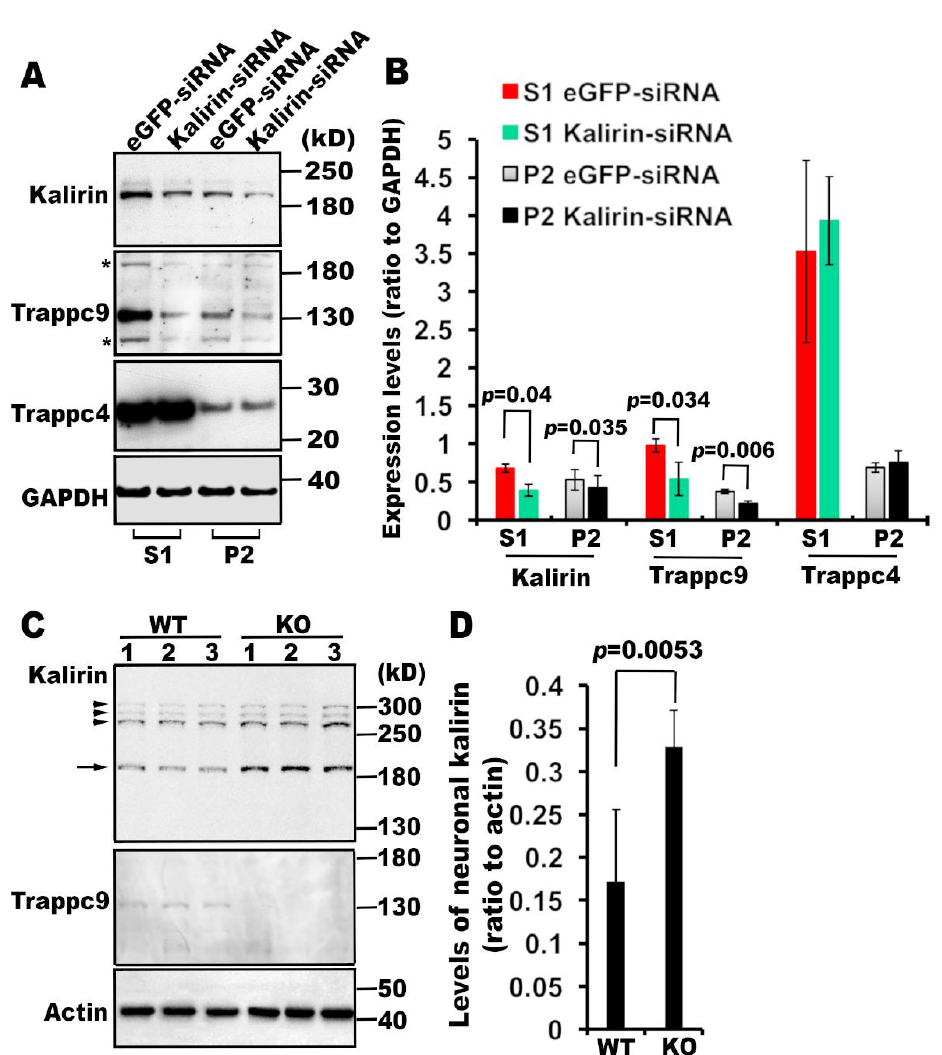
Figure 2. Kalirin and trappc9 mutually affect their expression. (A) and (B) Kalirin knockdown perturbs the expression as well as membrane association of trappc9. ( A ) Post-nuclear supernatants (S1) and cellular membranes (P2) from NRK cells treated with siRNAs for eGFP or kalirin were analyzed by Western blot with indicated antibodies. Shown are blot analyses from one of three experiments with similar results. Note that the blots were re-probed with anti-trappc9 antibodies after incubation with anti-kalirin antibodies, therefore signals detected by anti-kalirin antibodies still persisted as indicated by stars (*). ( B ) Films with signals in linear ranges were scanned into digital images for measuring intensities of signals for each protein and corresponding background signals using NIH ImageJ. Data are expressed as ratio of signal intensity of the indicated protein to that of GAPDH (n=3, Mean SD, two-tailed Student’s t -test). ( C ) and ( D ) Constitutive loss of trappc9 causes elevated expression of kalirin in brain neurons. ( C ) Western blot analysis of post-nuclear supernatants from brain tissues of three wild-type (WT) and three trappc9 knockout (KO) mice. The genotype of all mice was determined by PCR. The age of all mice used for harvesting brain tissues was 3 months. The arrow points to the neuronal isoform of kalirin (190kD), whereas arrowheads indicate other kalirin isoforms. ( D ) Intensities of signals for the neuronal kalirin isoform as well as actin and background in the same lane were measured with NIH Image J as above and used for calculating Mean SD ratio of neuronal kalirin to actin signals. Comparison was performed with two-tailed Student’s t -test.